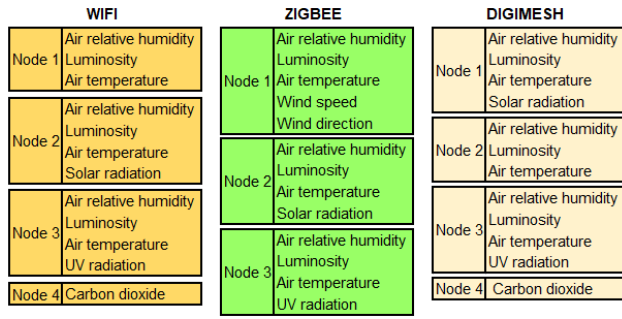
Figure 11. Distribution of the environmental variables for the sensor nodes of the three